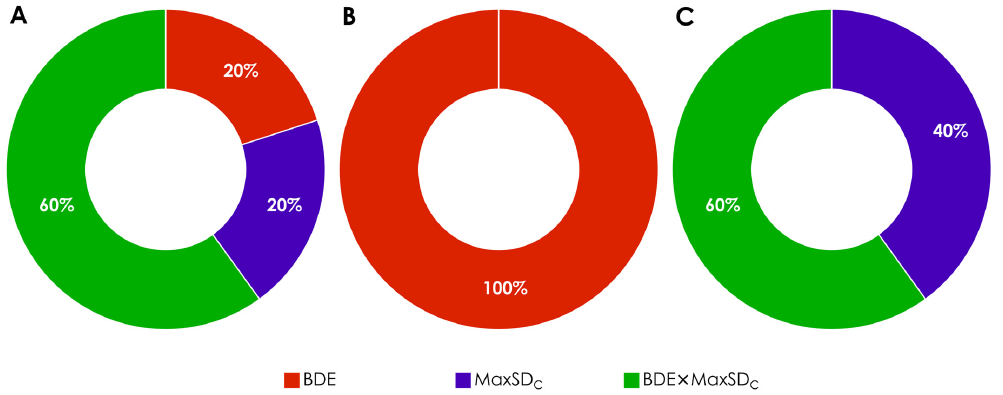
Figure 8. Distribution of radical-stability-related electronic parameters in the descriptors with the highest classification performance (best 20 models, 10 for each of the ABTS ● + and DPPH ● assays) for the explored datasets. ( A )—original dataset (88 compounds), ( B )—non-chromans subgroup (48 compounds), ( C )—chromans subgroup (40